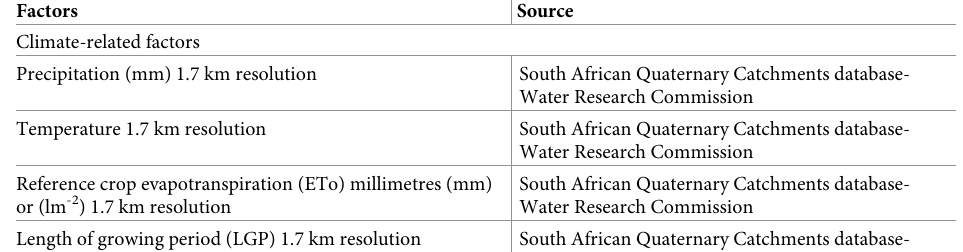
Soil and landscape attributes used to delineate land suitability maps for neglected and underutilised crop species Soil depth at 250 m resolution